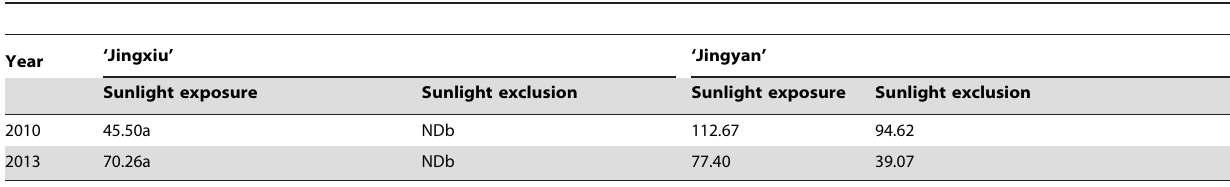
Table 1. Total anthocyanin concentration (mg/100 g fresh weigh) in berry skin for ‘Jingxiu’ and ‘Jingyan’ under conditions of sunlight exposure and sunlight exclusion in 2010 and 2013.